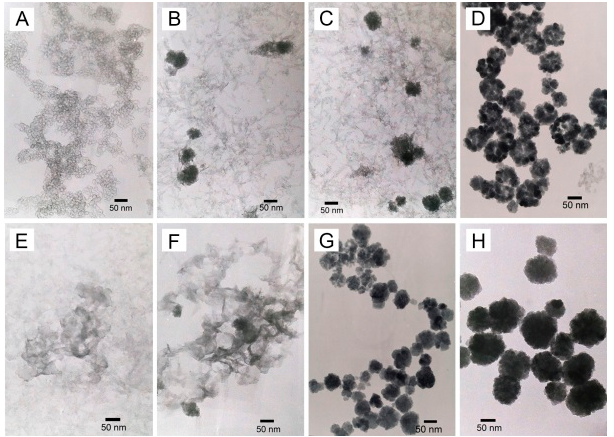
Figure 4. TEM images of the intermediates obtained from the synthesis systems for CNA1 ( A – D ) and CNA3 ( E – H ) at the synthetic times of 0.5 h ( A , E ), 1 h ( B , F ), 2 h ( C , G ) and 4 h ( D , H ).